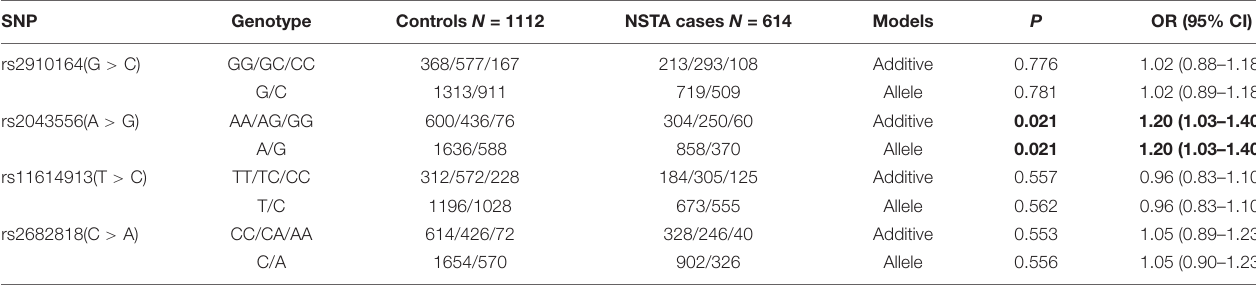
TABLE 1 | Overall associations between the four SNPs and non-syndromic tooth agenesis (NSTA) susceptibility.